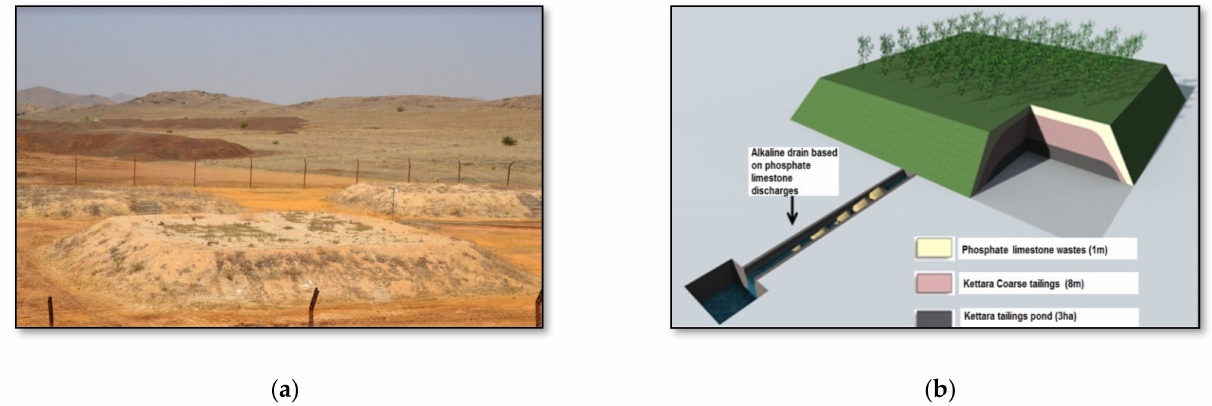
Figure 1. ( a ) Experimental cells for SDR cover made with phosphate mine wastes; ( b ) approved scheme for the rehabilitation of the Kettara mine